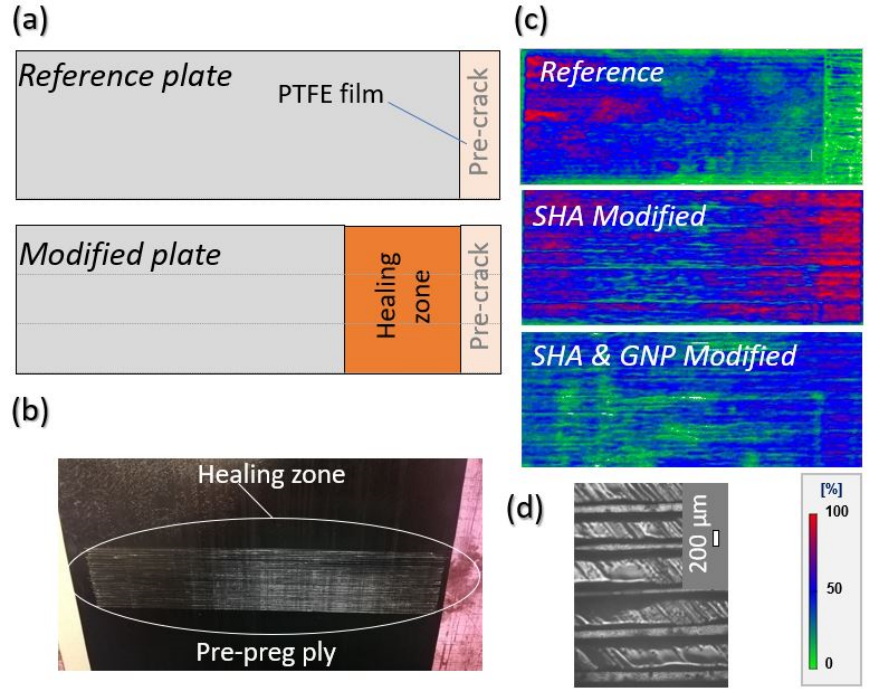
Figure 9. ( a ) Design of the reference and of the modified plates. ( b ) Depiction of the SHA surface- modified pre-preg ply by the melt electro-writing process (MEP) technique. ( c ) C-scan inspection images of all material sets (reference and modified ones). ( d ) Optical microscopy image, providing the fibrous mesh morphology employed for this study.